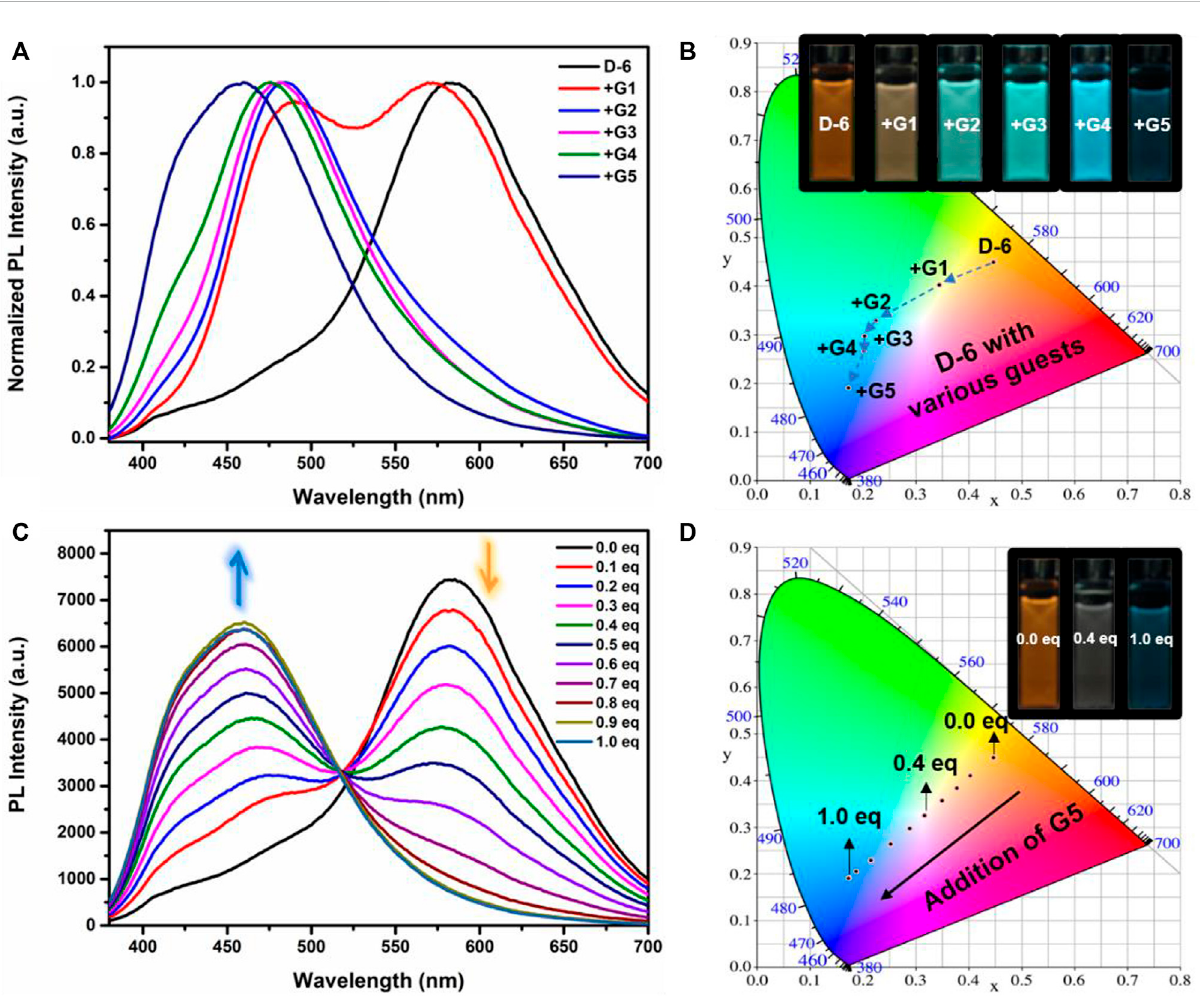
FIGURE 2 (A) Normalized fl uorescence emission spectra of D-6 alone (black) and in the presence of various guests [in dichloromethane; ( D-6 ) = 10 μ M; λ ex = 360 nm]. (B) Chromaticity coordinates (CIE) of D-6 and the host-guest complexes in dichloromethane. Inset: images of D-6 and D-6 uponirradiationwith360 nmUVlight. (C) Fluorescencecurvesupontitrationof0.1eq. G5 tothesolutionof D-6 [indichloromethane; λ ex =360